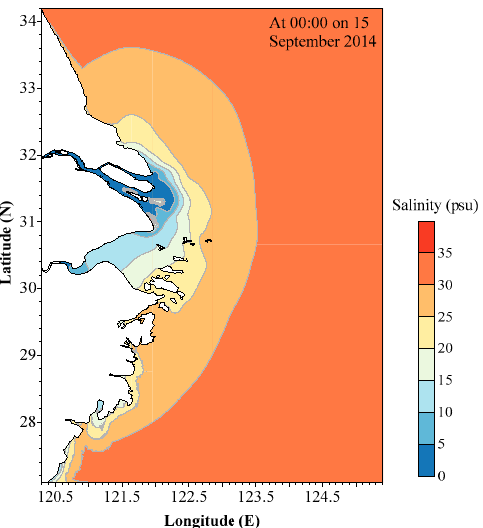
Figure 8. The salinity distribution at 00:00 on 15 September 2014.